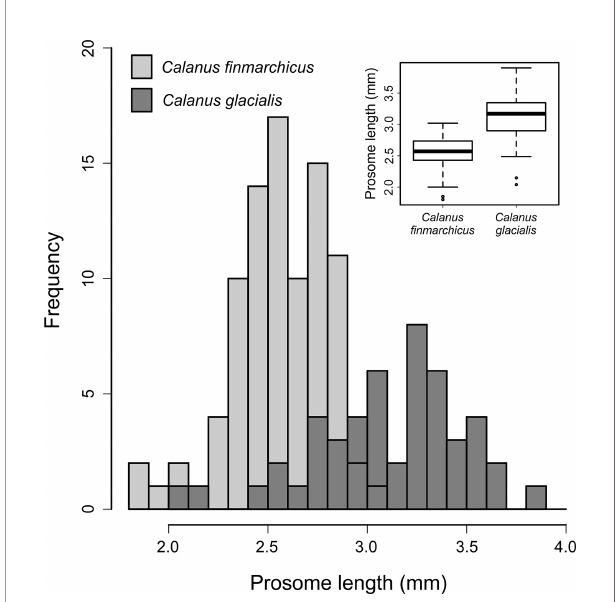
FIGURE 2 | Prosome length distribution of adult females of Calanus fi nmarchicus and Calanus glacialis from the Fram Strait. Inset boxplot shows the median prosome lengths (thick horizonal lines), their interquartile ranges (top and bottom of boxes = third and fi rst quartile, respectively) and 1.5 times the interquartile ranges